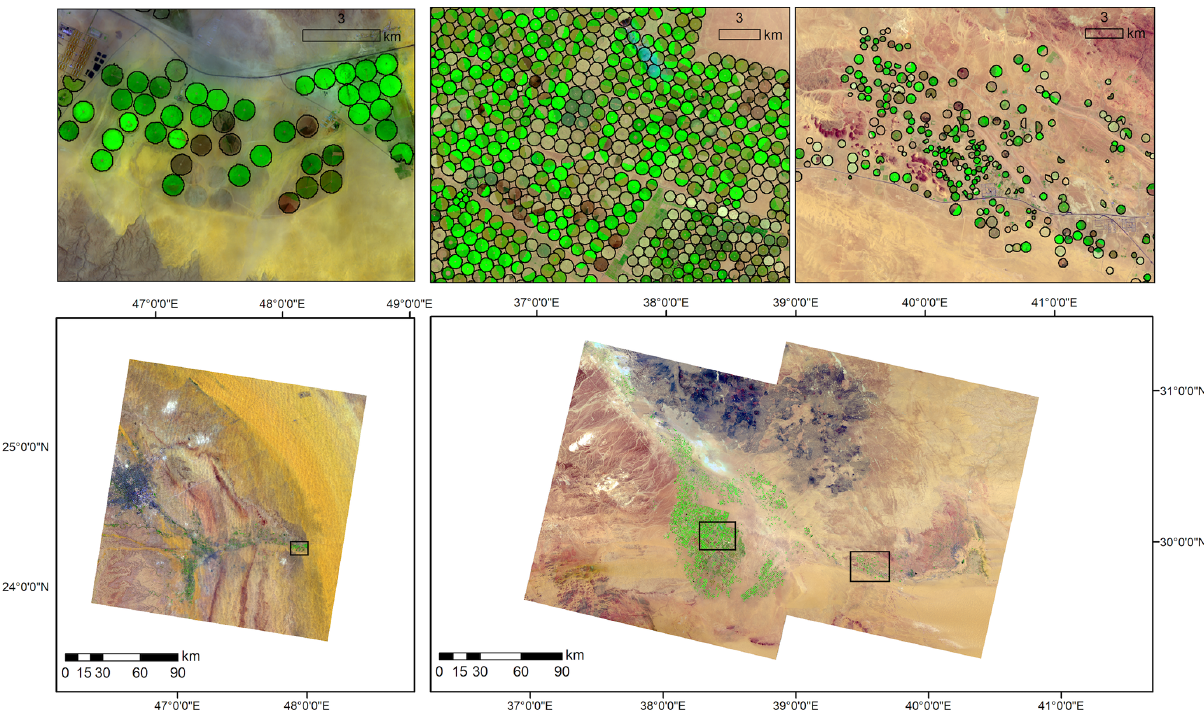
Figure 1. Location of the two study regions. Left: the Tawdeehiya farm in Al Kharj (southeast of Riyadh). A false color Landsat 8 image (9 June 2015) is shown to highlight active center-pivot fields over the desert environment. Right: the Al Jawf agricultural region in the northwest of Saudi Arabia spans two Landsat 8 tiles. Two false color images are shown: 9 June 2015 for path/row 172/39 (left) and 19 June 2015 for path/row 171/39 (right). Center-pivot fields are densely packed and largely uniform in size in the main area (30 ◦ N, 38.25 ◦ E), while in other areas they are sparser and less uniform (for example, the image on the